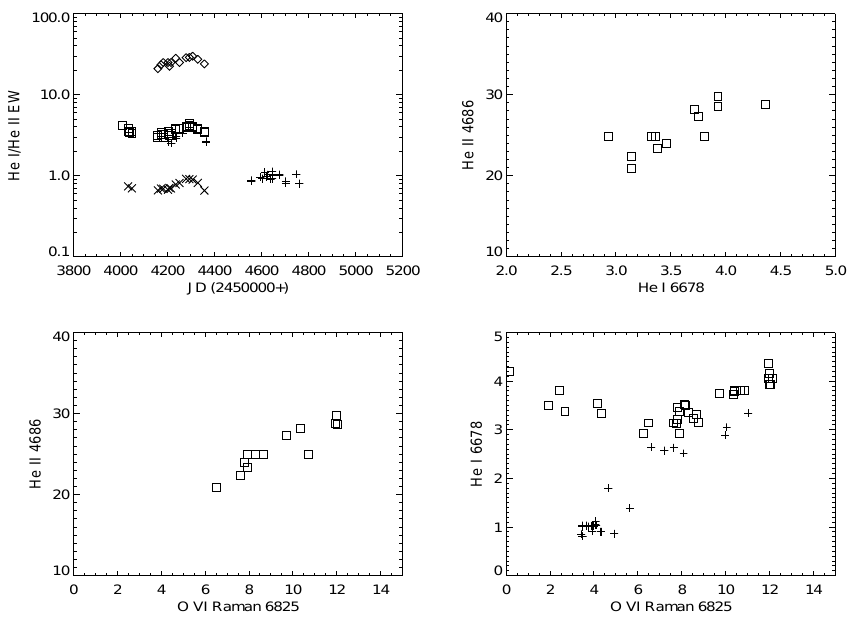
Fig. 2. Variations of the He I, He II and O VI Raman 6825 ˚A line during the 2006–2008 eruption from the Loiano and Ondˇrejov spectra. Top left: He I 6678 ˚A (square), He I 7065 ˚A (cross) and He II 4686 ˚A (diamond) variations in time. Top right: He I 6678 ˚A vs. He II 4686 ˚A. Bottom left: He II 4686 ˚A vs. O VI Raman 6825 ˚A. Bottom right: He I 6678 ˚A vs. O VI Raman 6825 ˚A. Note the bifurcation in the last